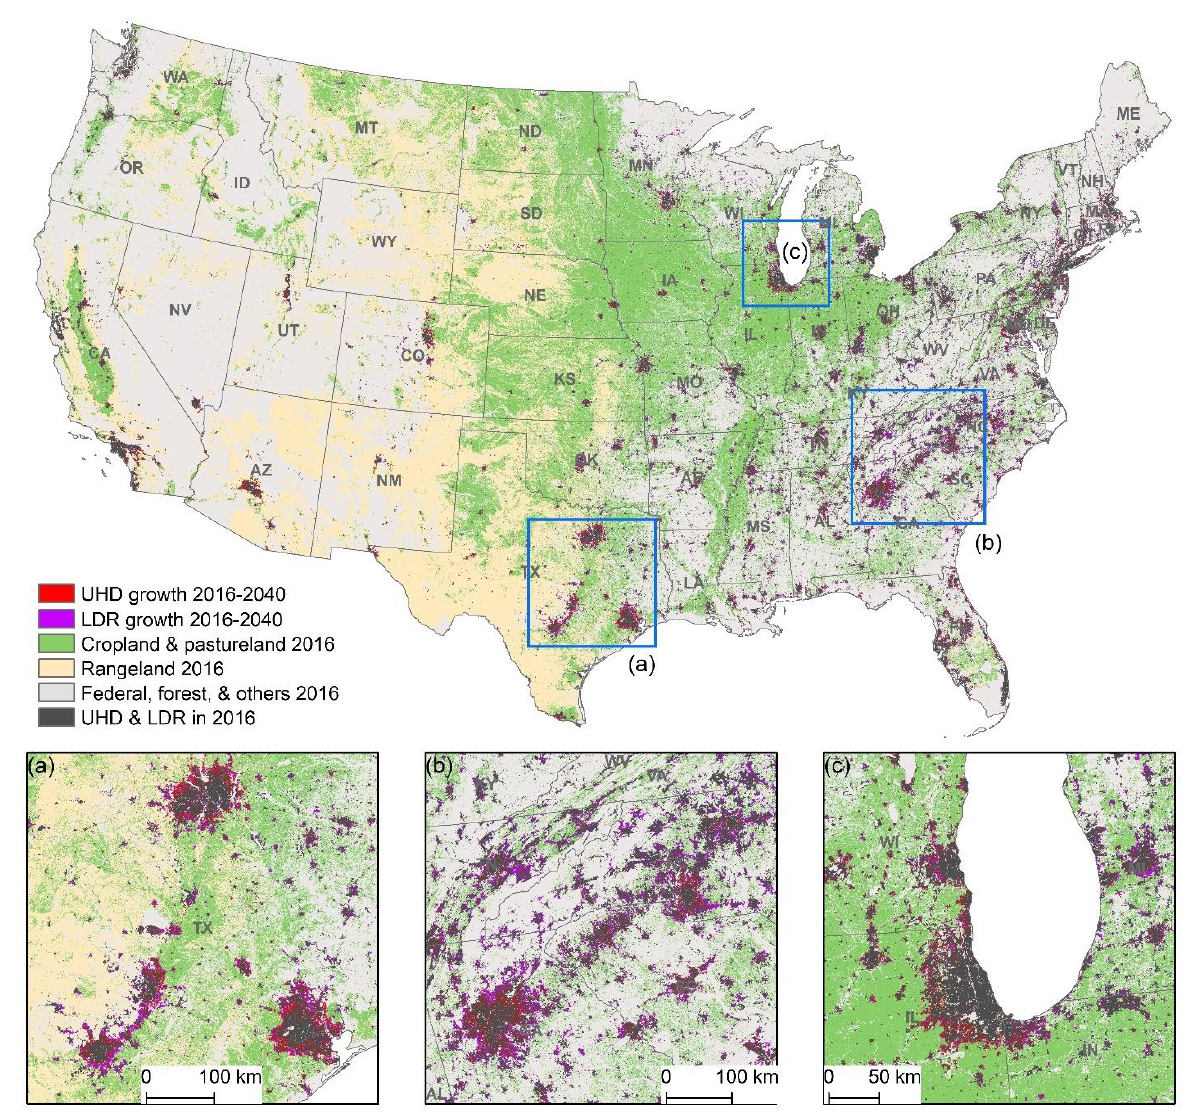
Figure 7. Projected urban and highly developed (UHD) and low-density residential (LDR) growth by 2040 under the business-as-usual scenario. The highlighted areas are ( a ) Dallas – Houston – Austin – San Antonio, TX, ( b ) the South Atlantic region, and ( c ) the greater Chicago region.